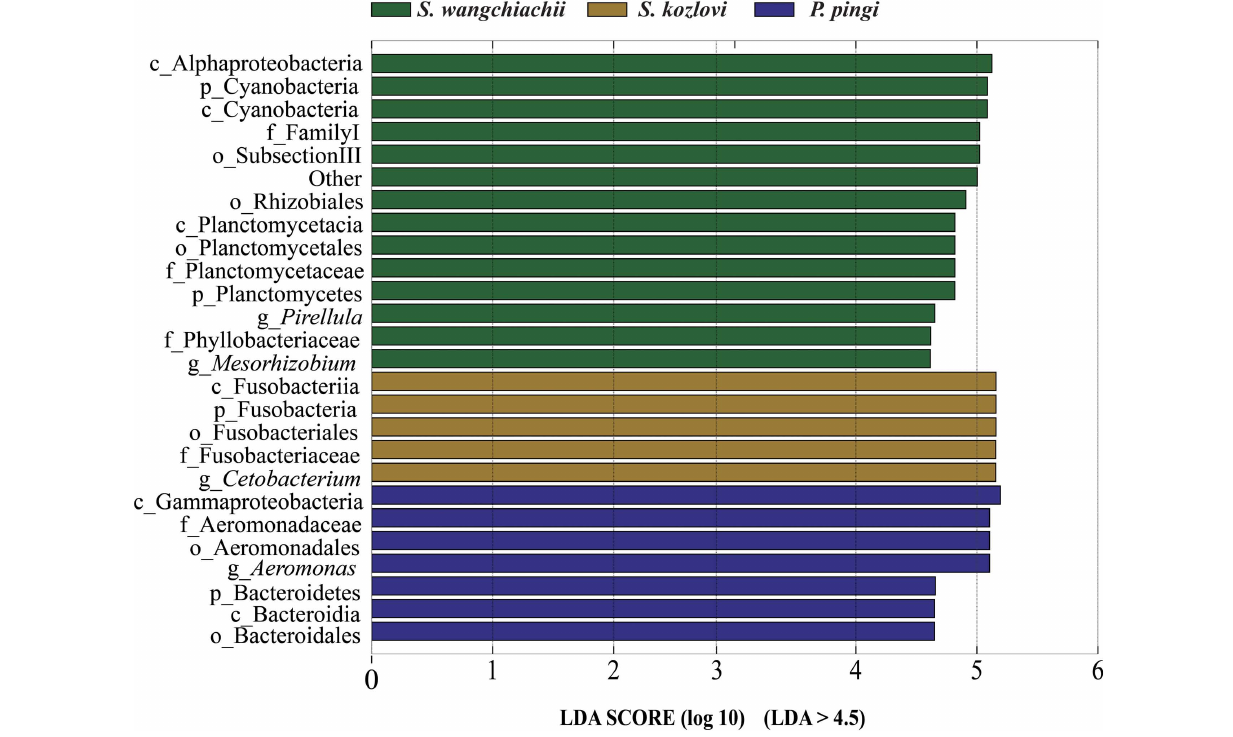
Frontiers in Microbiology |